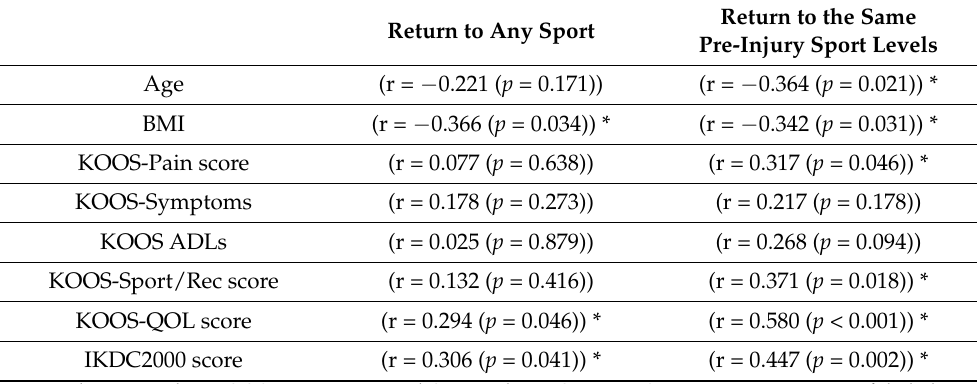
Table 2. Pearson correlations between return to sport and return to pre-injury sport levels, and